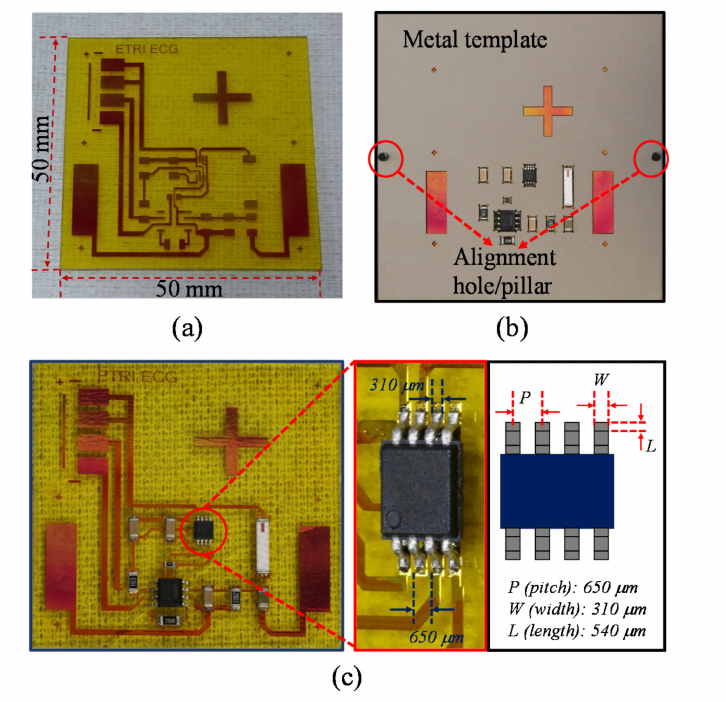
Figure 4. Optical images of products from various stages of the fabrication procedure: ( a ) a fabricated sensor device platform; ( b ) passive alignment of chip components on the sensor device platform using the metal template; ( c ) the complete sensor device. The magnified image shows the smallest active component on the circuit and its dimensions.